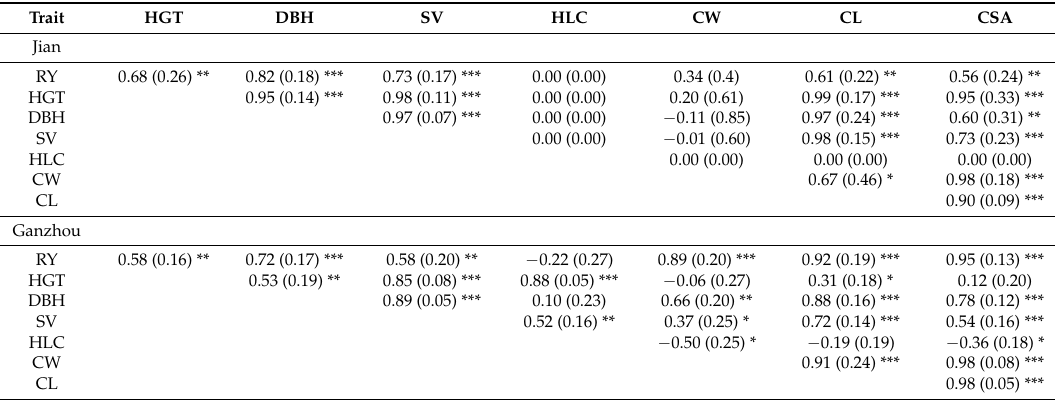
Table 6. Estimated intertrait genetic correlations (with standard error in parenthesis) among resin yield, growth traits and morphologic traits across the three study